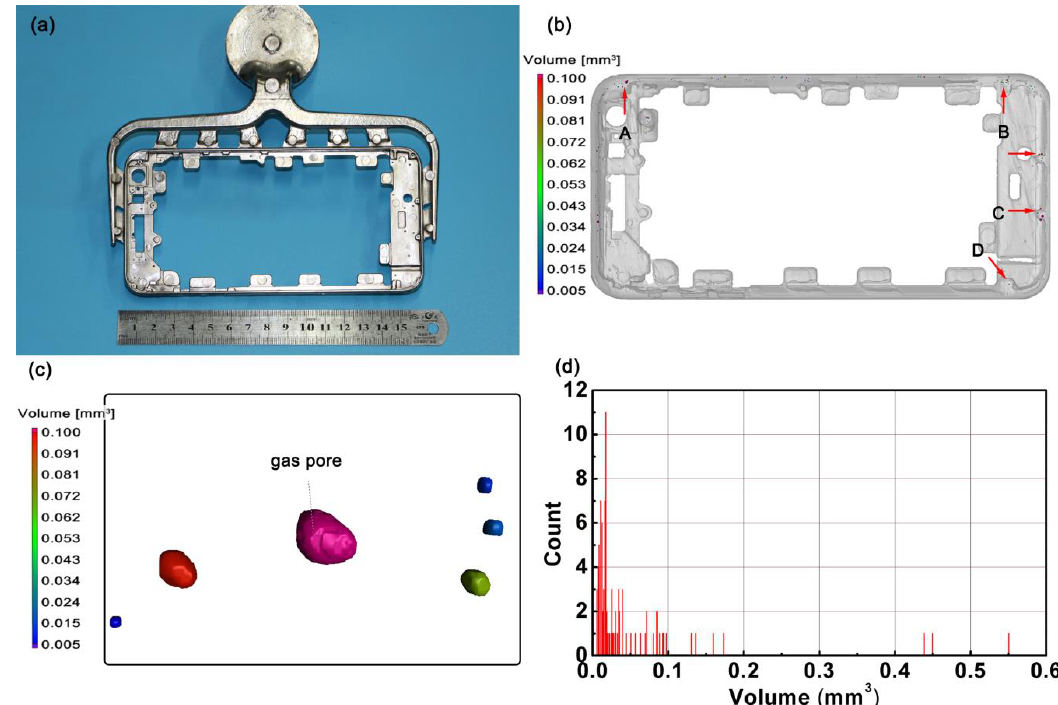
Figure 5. ( a ) Image of Zr 55 Cu 30 Ni 5 Al 10 BMGs smartphone frame and the corresponding runner system; ( b ) the 3D distribution of the porosity in the smartphone frame, A, B, C, and D denote different regions; ( c ) morphologies of the gas pores; ( d ) statistics of the pores with a different size in casting.